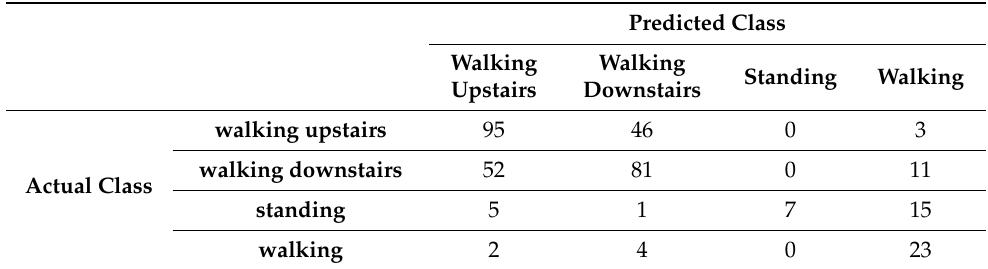
Table 2. Confusion matrix for normalized gyroscope data with